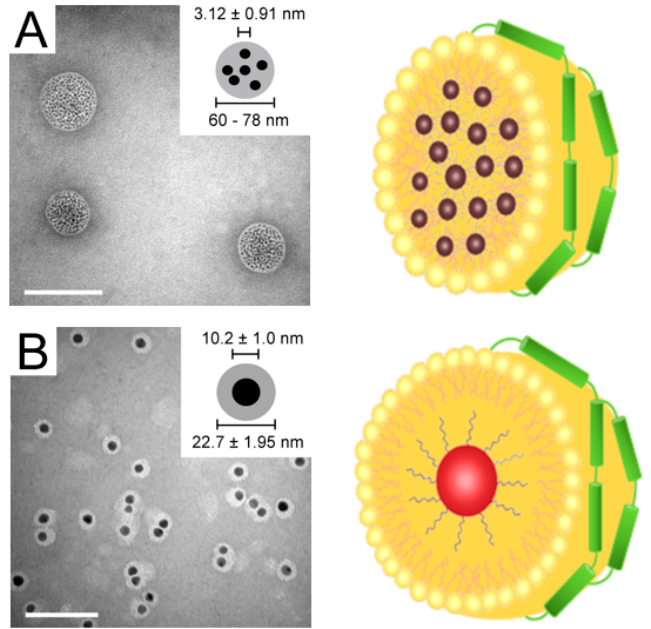
Figure 8. Nanolipoproteins reconstituted with 3 nm and 10 nm AuNP. TEM image ( Left ) and schematic representation ( Right ) of 3 nm ( A ) and 10 nm ( B ) AuNP incorporated into rHDL / apoE3. The scale bar represents 100 nm in TEM images. TEM image of rHDL-AuNP prepared with 3 nm AuNP ( A ) revealed 60–80 nm spheroid structures with several AuNP (Inset, A ), while that prepared with 10 nm AuNP revealed ~23 nm spherical structures with a single AuNP (Inset, B ). The light area around the 10 nm AuNP likely represents the lipoprotein shell. Reproduced with permission from [64]. Copyright Dove Medical Press,